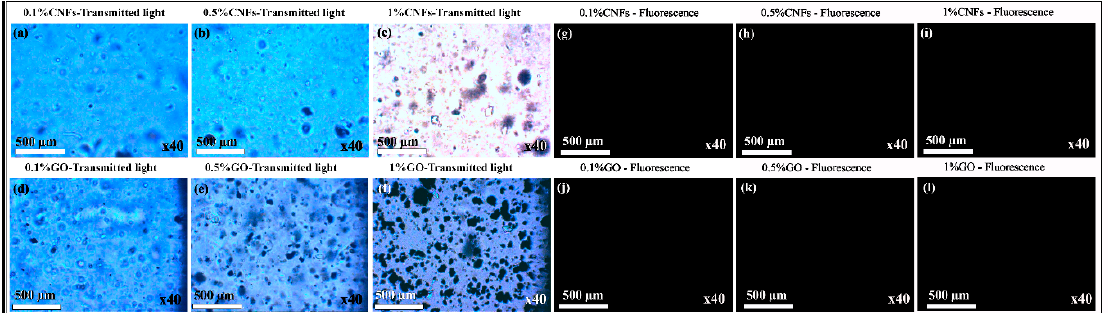
Figure 4. Cell adhesion results of human keratinocyte HaCaT cells on calcium alginate films with 0.1%, 0.5% and 1% w/w of CNFs and GO by optical microscopy in transmission light mode ( a – f ) and fluorescence microscopy (DAPI and Phalloidin-FITC staining) ( g – l ). The magnification of the utilized objective lens is indicated for each image. No cell adhesion on any of the composite films was observed by either optical or fluorescence microscopy.